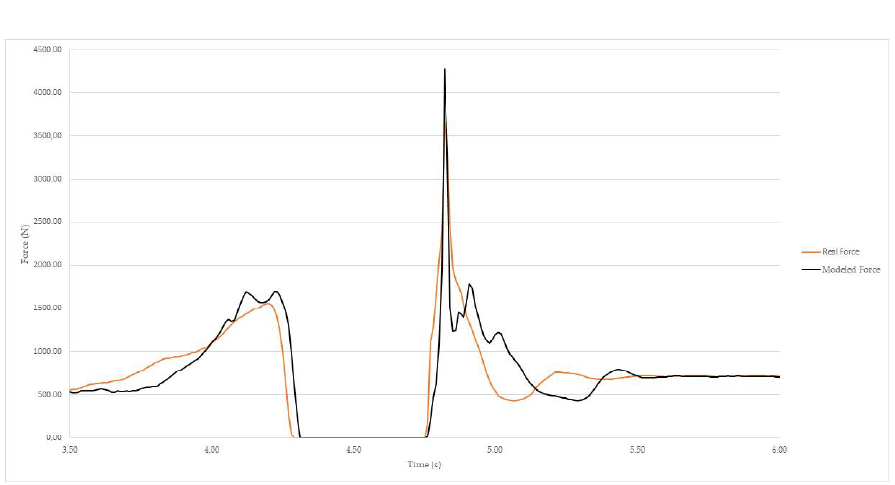
Figure 11. Example of the comparison between the actual and the modeled force curves during a jump.